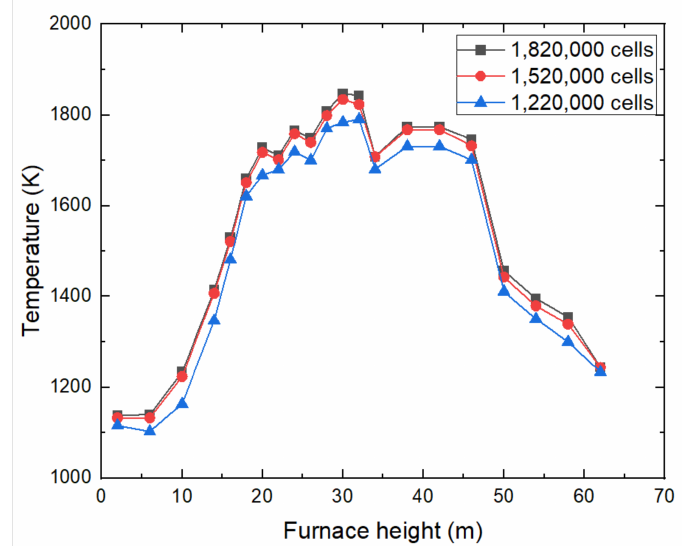
Figure 4. Temperature distribution along furnace height.